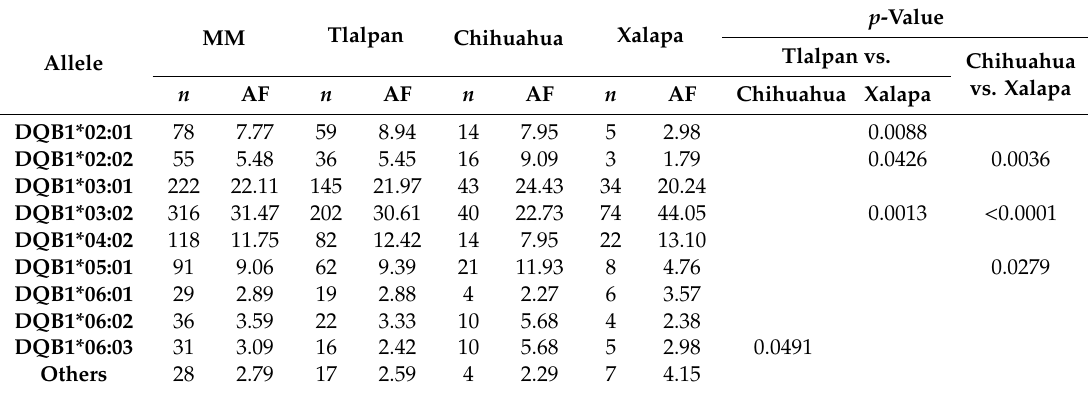
Table 5. HLA-DQB1 allele frequency from Mexico: Tlalpan, Chihuahua, and Xalapa.